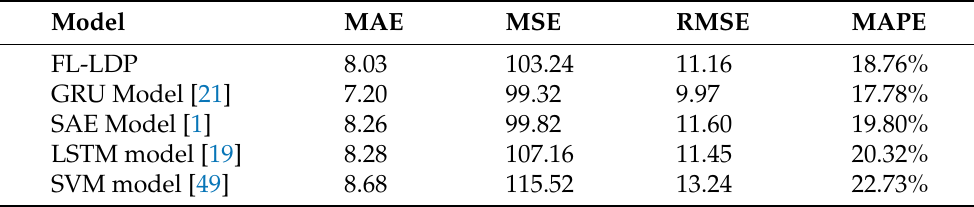
Table 2. Performance comparison of FL-LDP , LSTM, SAE, and SVM